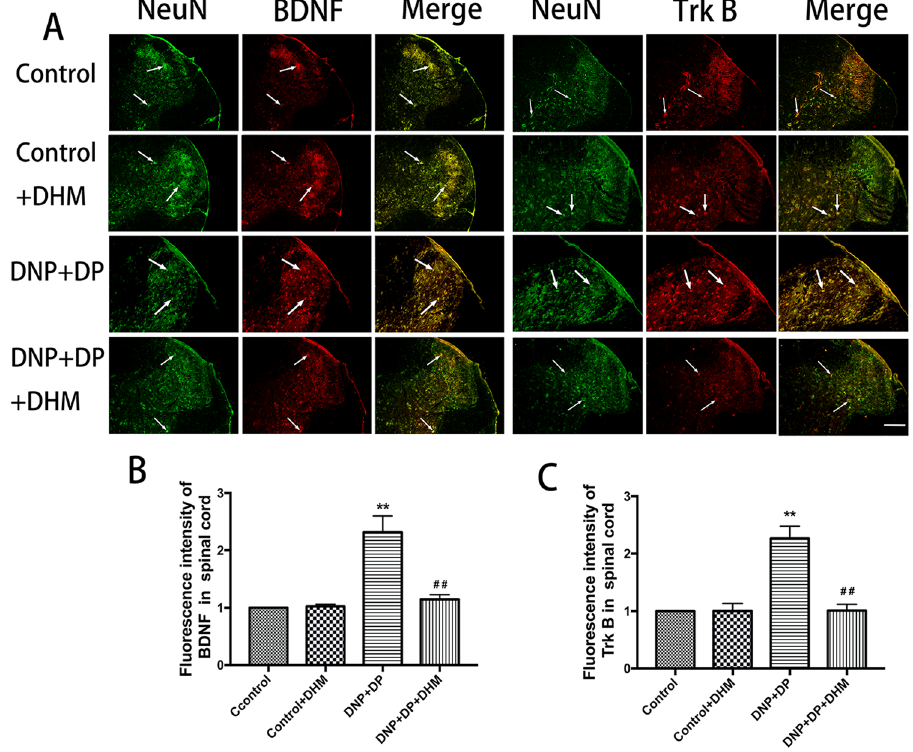
Figure 6. Co-expression of NeuN-BDNF ( A , B ) and NeuN-TrkB ( A , C ) in the spinal cord was detected with double-labelled immunofluorescence. Values are the mean ± SEM of 3 observations. ** p < 0.01 vs . control group; ## p < 0.01 vs . DNP + DP group. Scale bar: 100 μ